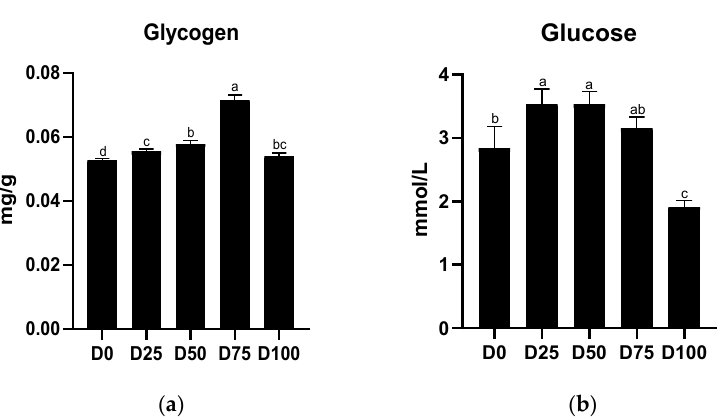
Figure 3. Effects of eugenol on the concentrations of ( a ) liver glycogen and ( b ) serum glucose in the greater amberjack under simulated transport conditions. Different letters above bars indicate significant differences at the 0.05 level.